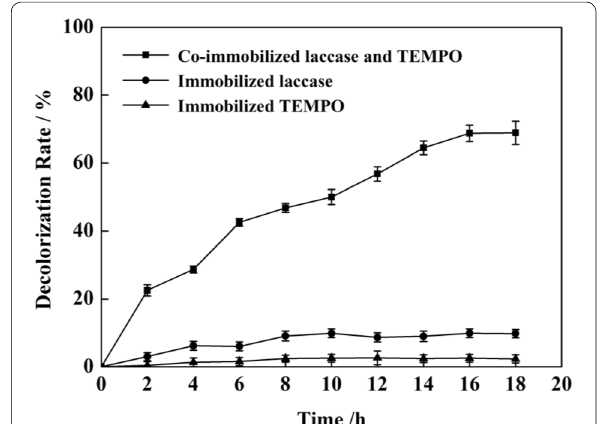
Fig. 5 Decolorization of acid fuchsin by different Fe 3 O 4 nanoparticles. The co-immobilized laccase and TEMPO showed a